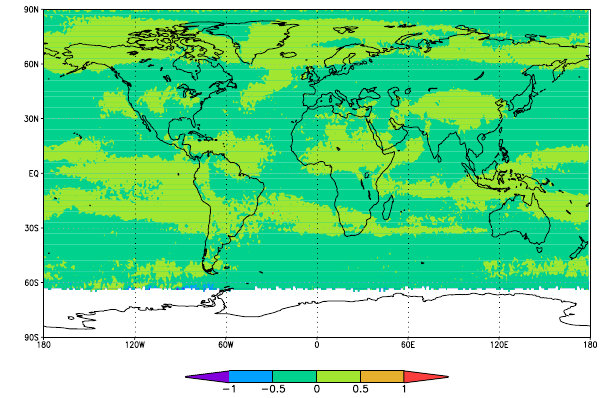
Fig. 3. SO 2 Column Amount (Middle Troposphere) from OMI L2G product in Dobson Units for June, July and August in 2006. The color scale has been restricted; the lowest and highest spots are close to − 2 and 2,